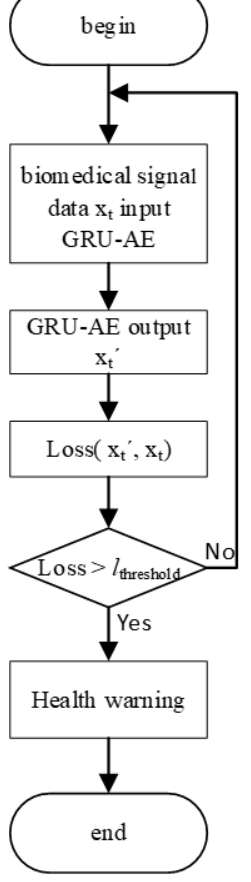
Figure 9. Workflow of monitoring.